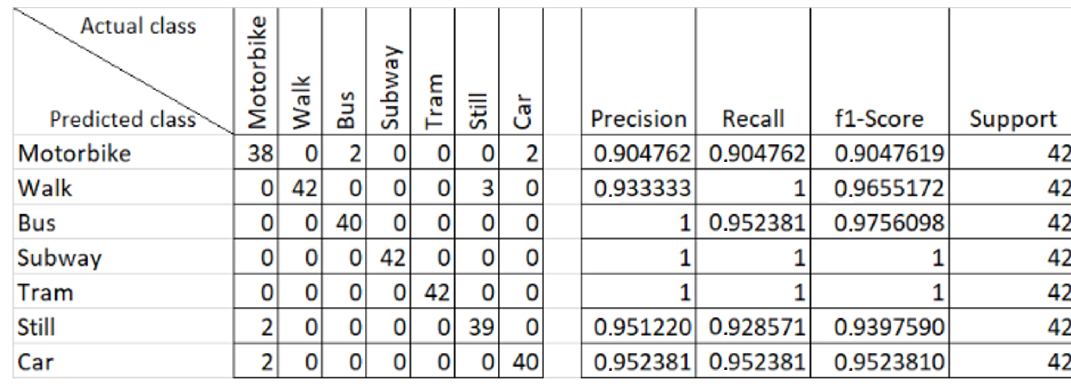
Figure 7. Confusion matrix for the Deep Convolutional Neural Network (DeepCNN).